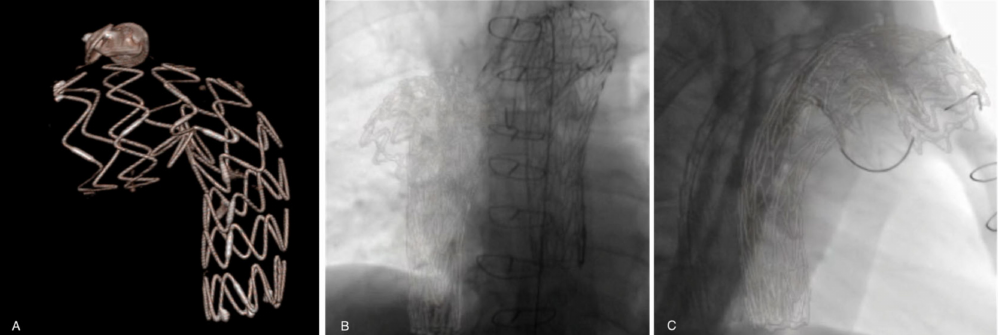
Figure 2. ( A ) A previous thoracic stent-graft three-dimensional volume rendering model recon- structed from the preoperative CTA. Registration and overlay are performed with two fluoroscopic orthogonal antero-posterior ( B ) and lateral ( C )